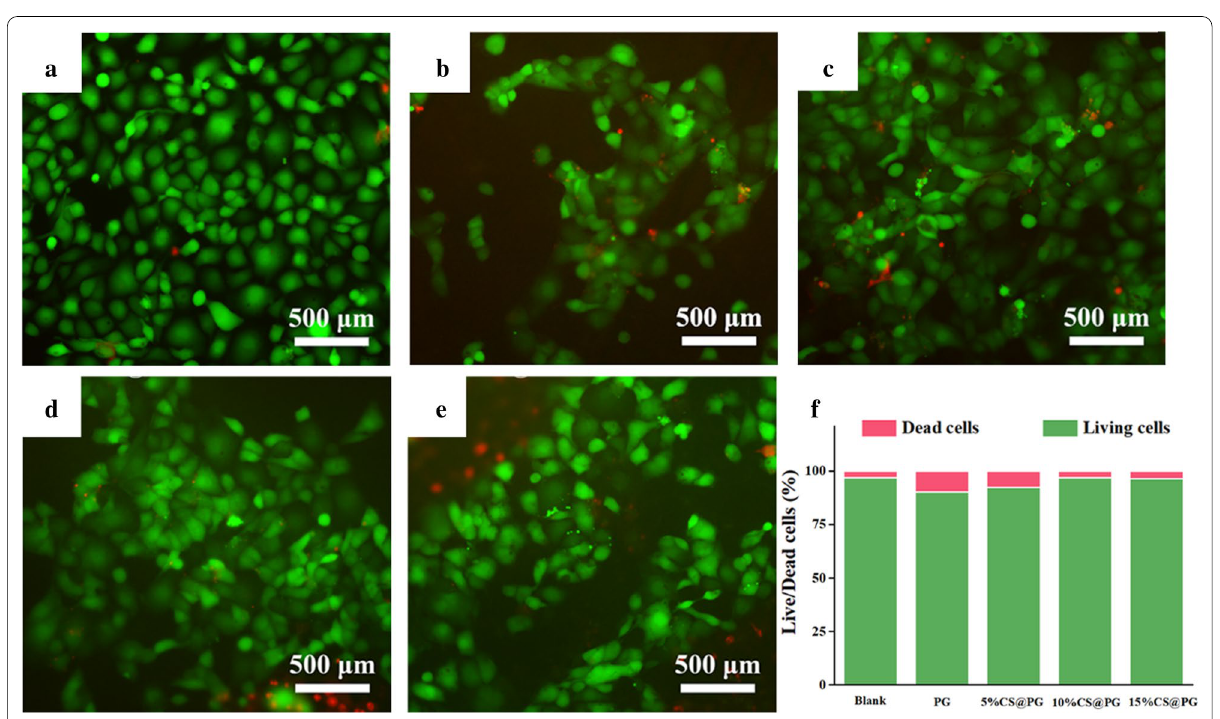
Fig. 7 Cell viability of HAECs on the CS@PG scaffolds. a Tissue culture plate (TCP), b PG, c 5%CS@PG, d 10%CS@PG, e 15%CS@PG, f The percentage of Live/Dead cell numbers of different nanofibrous scaffolds, n =